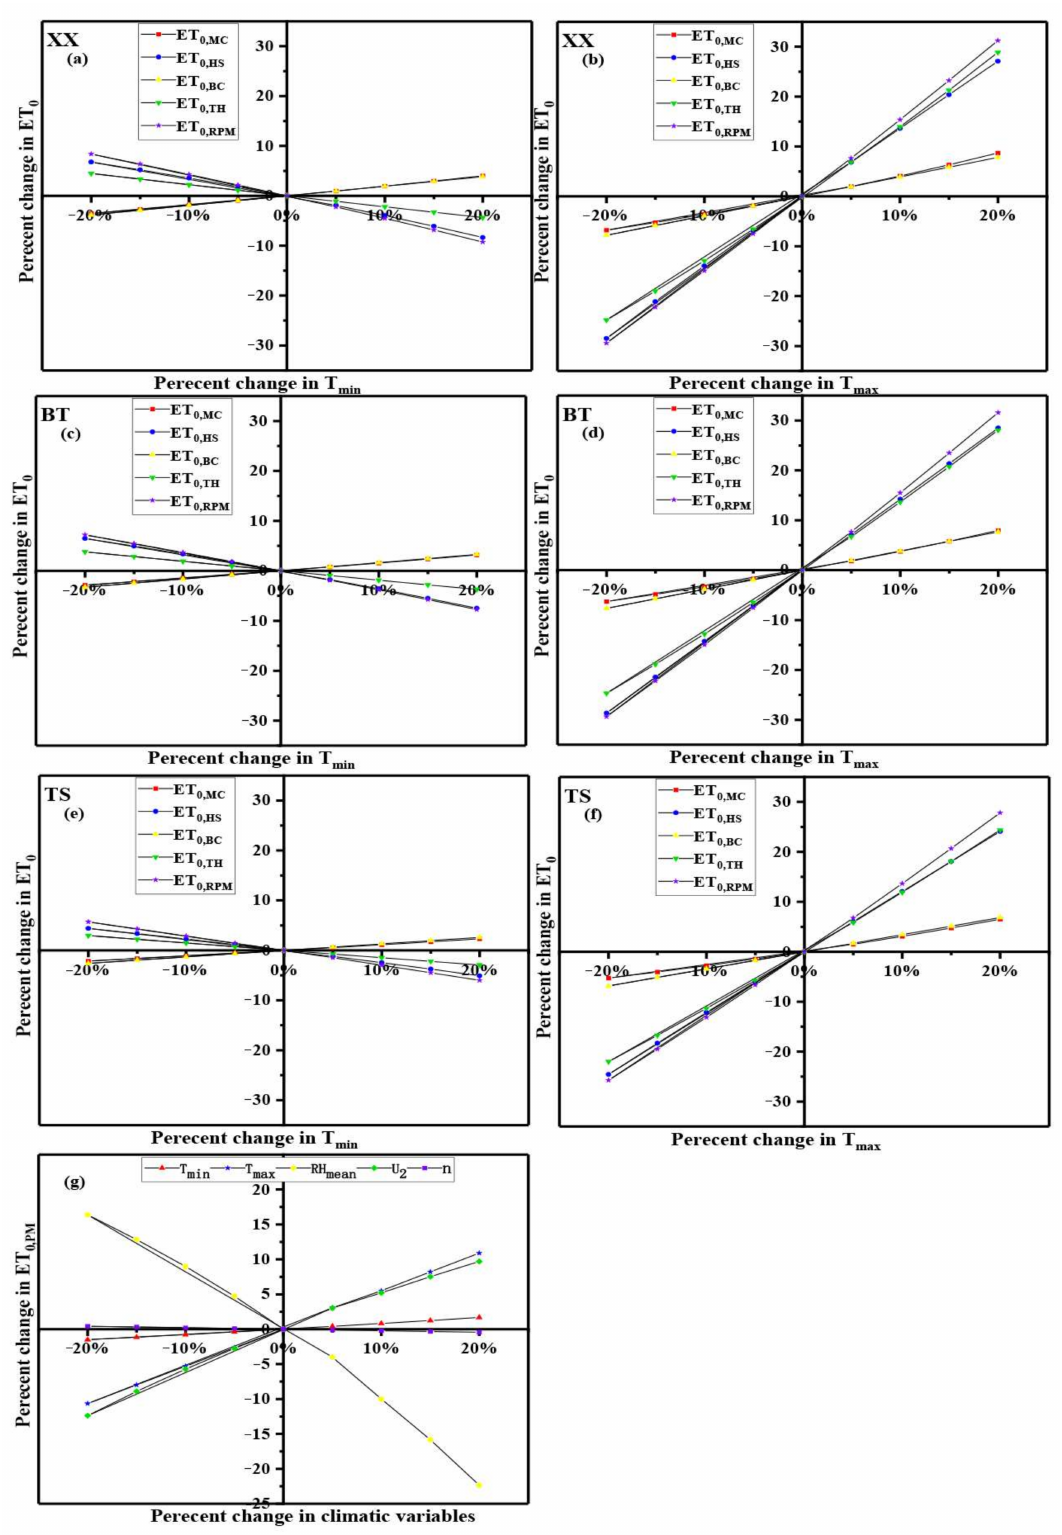
Figure 7. Percentage change in ET 0 forecasts with respect to the percentage change in temperature for stations BT, TS, and XX; T min ( a , c , e ), T max ( b , d , f ); percentage change in ET 0,PM with respect to the percentage change in climatic variables ( g